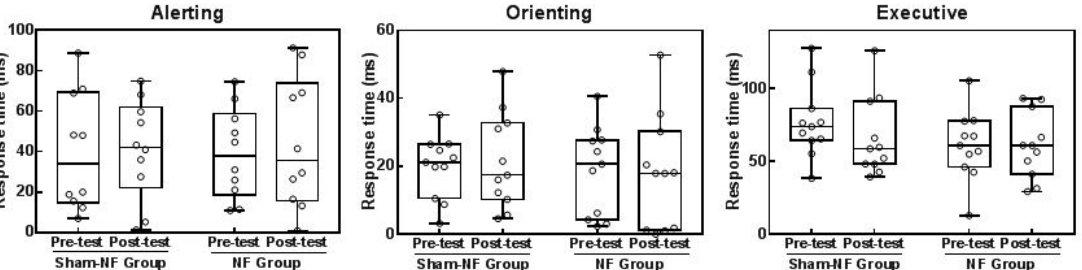
Figure 7. The response times (ms) scores of alerting, orienting and conflict in the pretest and posttest in Figure 7 both groups ( a – c ). The horizontal axis shows the group (NF and Sham-NF groups) and phase (pretest and posttest). The vertical axis shows the value of response times (ms). The horizontal line in each box indicates the mean of the value of response time in each group. The hollow circles represent personal